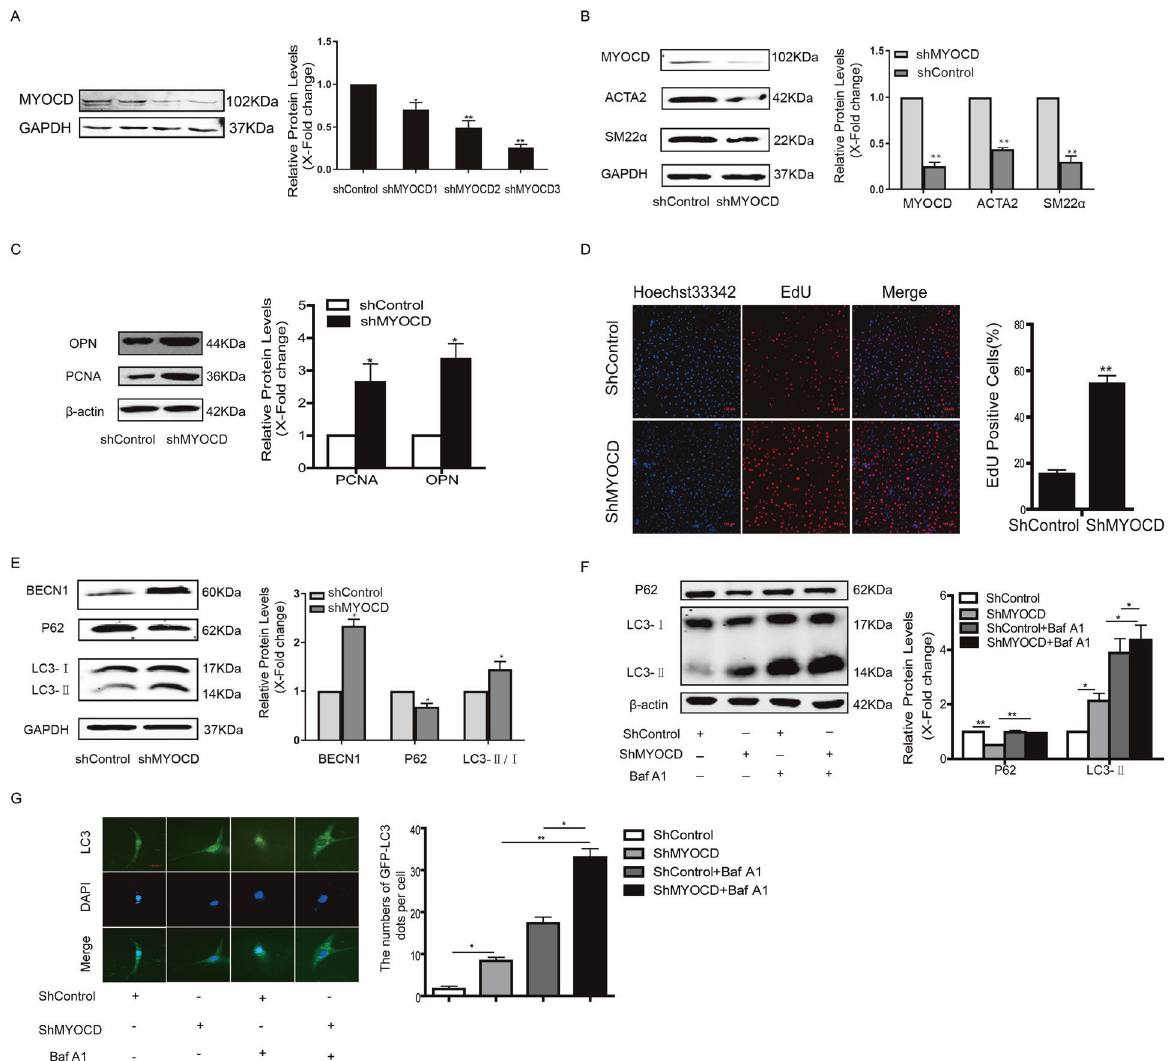
Fig. 1 Knockdown of MYOCD triggered autophagy in HA-VSMCs. A The expression of MYOCD was detected in HA-VSMCs transfected with shRNA speci fi cally targeting MYOCD by western blotting (* P < 0.05, ** P < 0.01, n = 3). B The expression of contractile proteins ACTA2 and SM22 was detected in MYOCD-knockdown HA-VSMCs by western blotting (** P < 0.01, n = 3). C The expression of OPN and PCNA was tested in MYOCD-knockdown HA-VSMCs by western blotting (* P < 0.05, n = 3). D Cellular proliferation was evaluated in MYOCD-knockdown HA-VSMCs by EdU staining (** P < 0.01, n = 3). E The expression of beclin1, P 62, and LC3 was tested in MYOCD-knockdown HA-VSMCs by western blotting (* P < 0.05, n = 3). F Ba fi lomycin A1 (0.1 μ g/mL) was added to control or MYOCD-knockdown HA-VSMCs 1 h prior to harvest, and accumulation of P62 and LC3 was measured by western blotting (* P < 0.05,** P < 0.01, n = 3). G Representative images and quanti fi cation of GFP-LC3 puncta in MYOCD-knockdown HA-VSMCs transfected with GFP-LC3 vector in the presence or absence of ba fi lomycin A1 (* P < 0.05,** P < 0.01, n = 3).